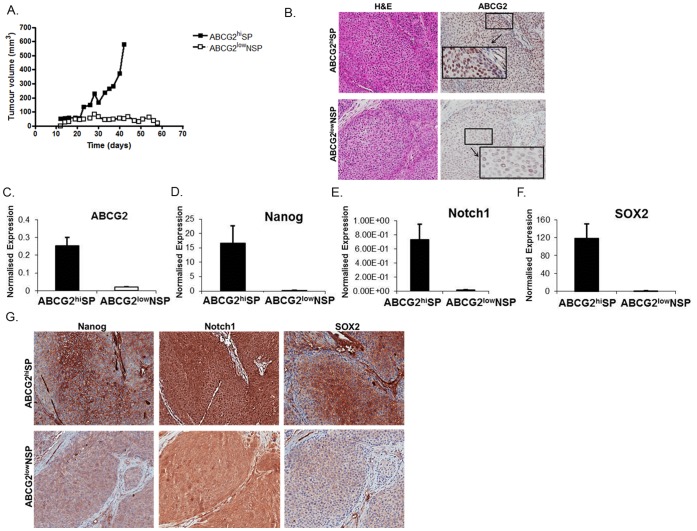
SP cells are more tumourigenic.(A) 1×103 ABCG2hi SP and ABCG2low NSP sorted RT112 cells were subcutaneously injected into nude mice and monitored for tumour growth. (B) Immunohistochemical staining of serial sections, of tumours derived from mice injected with 1×103 ABCG2hi SP and residual cell pellets from mice injected with 1×103 ABCG2low NSP sorted RT112 cells, with H&E and ABCG2 and at higher magnification (20x). Markedly increased immunoreactivity for ABCG2 is seen in the ABCG2hiSP derived tumours. (C) Relative mRNA expression of ABCG2 in tumours formed following injection of 1×103 ABCG2hi SP and ABCG2low NSP sorted RT112 cells was determined using real time PCR. (D–F) Relative mRNA expression of Nanog, Notch1 and SOX2 in tumours formed following injection of 1×103 ABCG2hi SP and ABCG2low NSP sorted RT112 cells was determined using real time PCR. (G) Immunohistochemical staining of serial sections, of tumours formed following injection of 1×103 ABCG2hi SP and ABCG2low NSP sorted RT112 cells, with Nanog, Notch1 and SOX2.